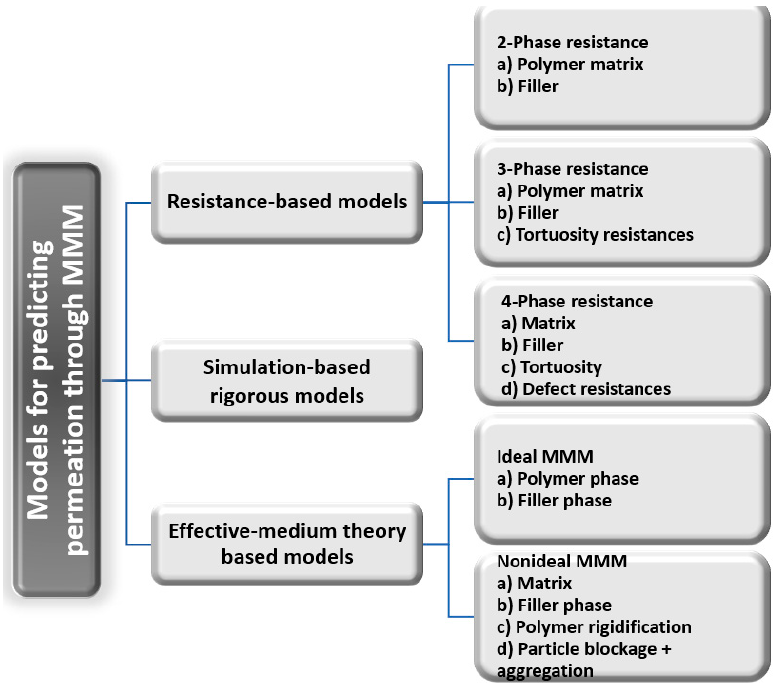
Figure 1. Models commonly used for predicting permeability of gases in mixed matrix membranes (MMMs).